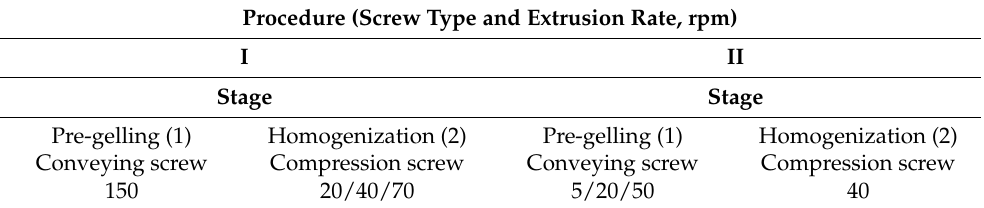
Table 1. Extrusion procedures for improving the component